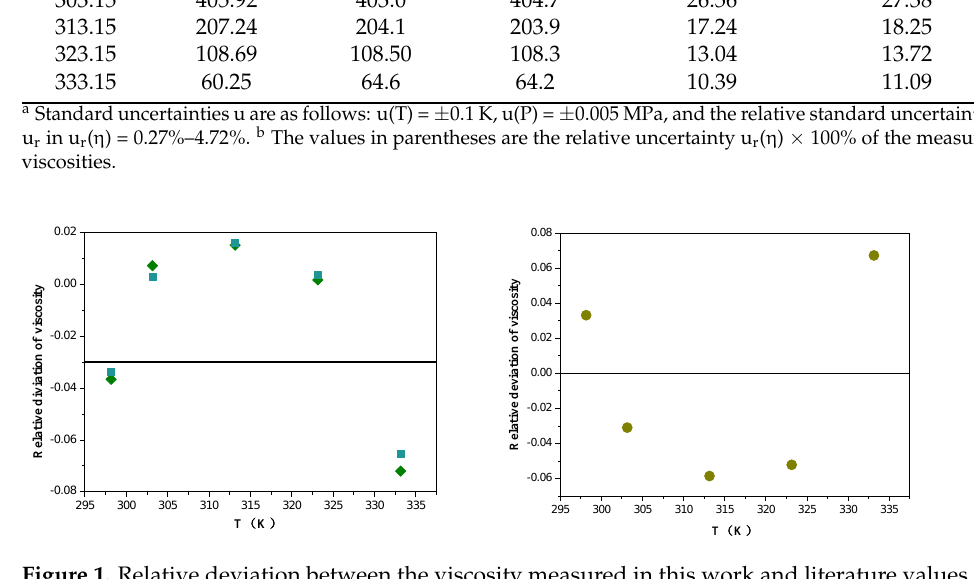
Figure 1. Relative deviation between the viscosity measured in this work and literature values for TEA and [EMIM] [TFA]: ( ) [33,40]; ( ) [34]; ( ) [35,36].